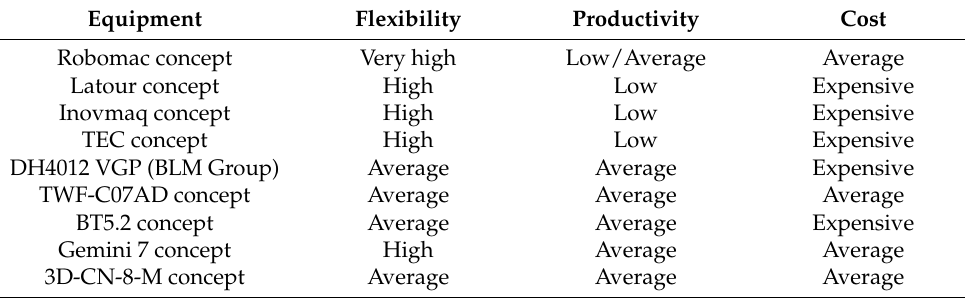
Table 1. Some of the main features of the analyzed